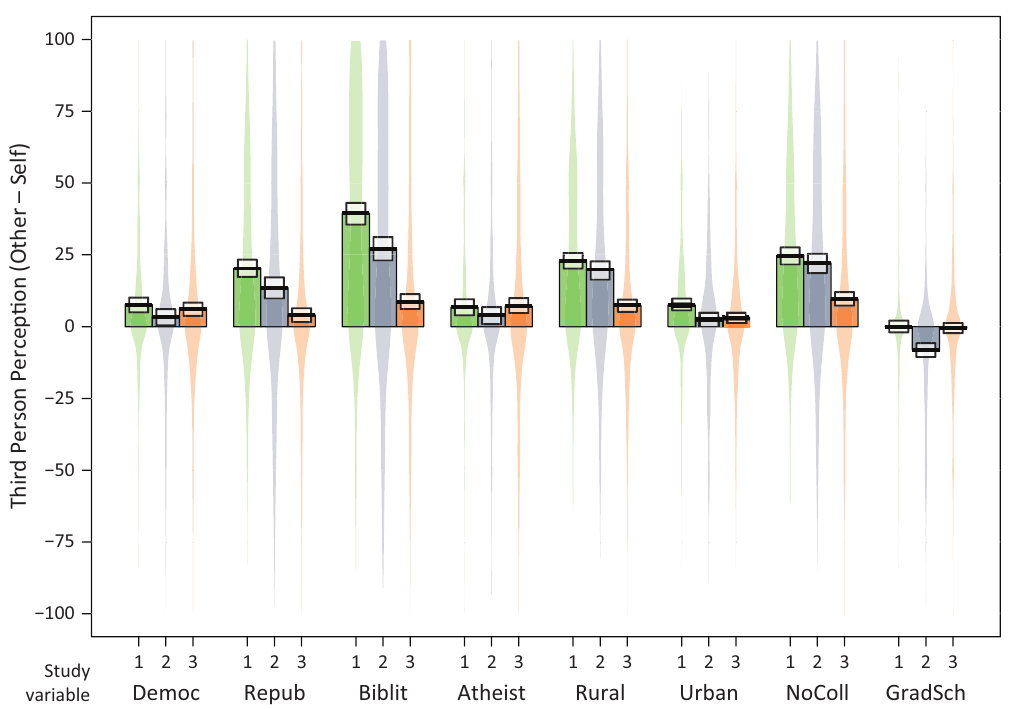
Figure 1. TPP scores for each identity group across the three studies. Independent (n = 142), Republican (n = 60), and strong Republican (n = 20), with an additional option of ‘I choose not to answer’ (n = 11). To reduce the number of comparison groups, strong Democrat and Democrat were combined into one response level, ‘Democrat’ (n = 164), and strong Republican and Republican were combined into one response level, ‘Republican’ (n =